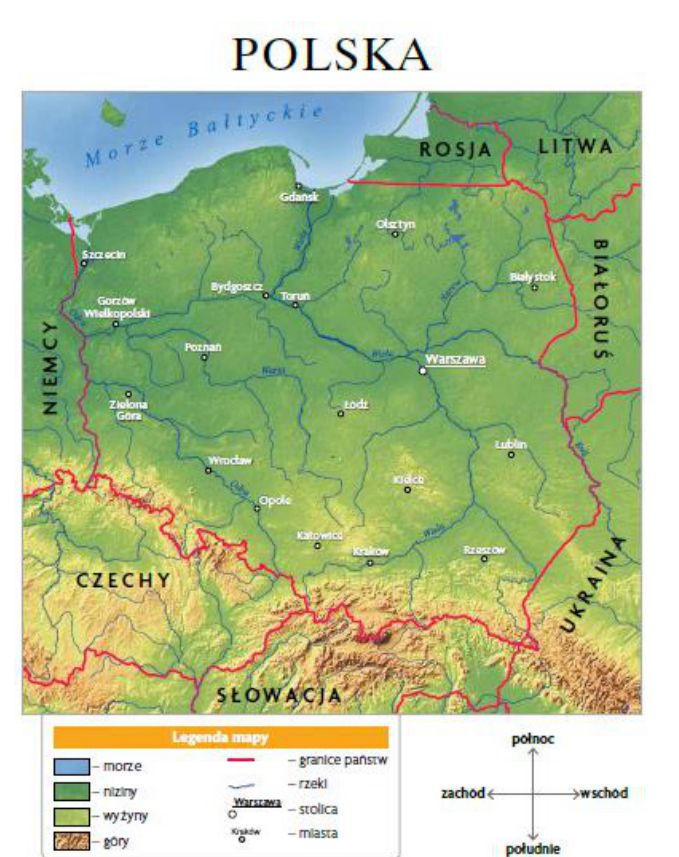
Fig. 4. The map of Poland from Nasza szkoła (reduced, source: M. Lorek, M. Zatorska,